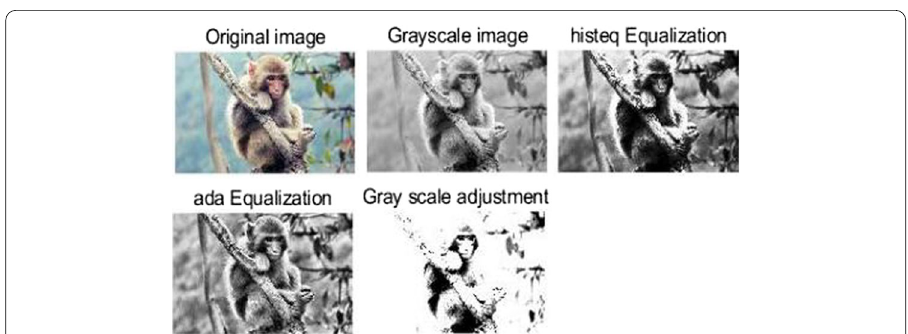
Fig. 7 Detection image results of three different